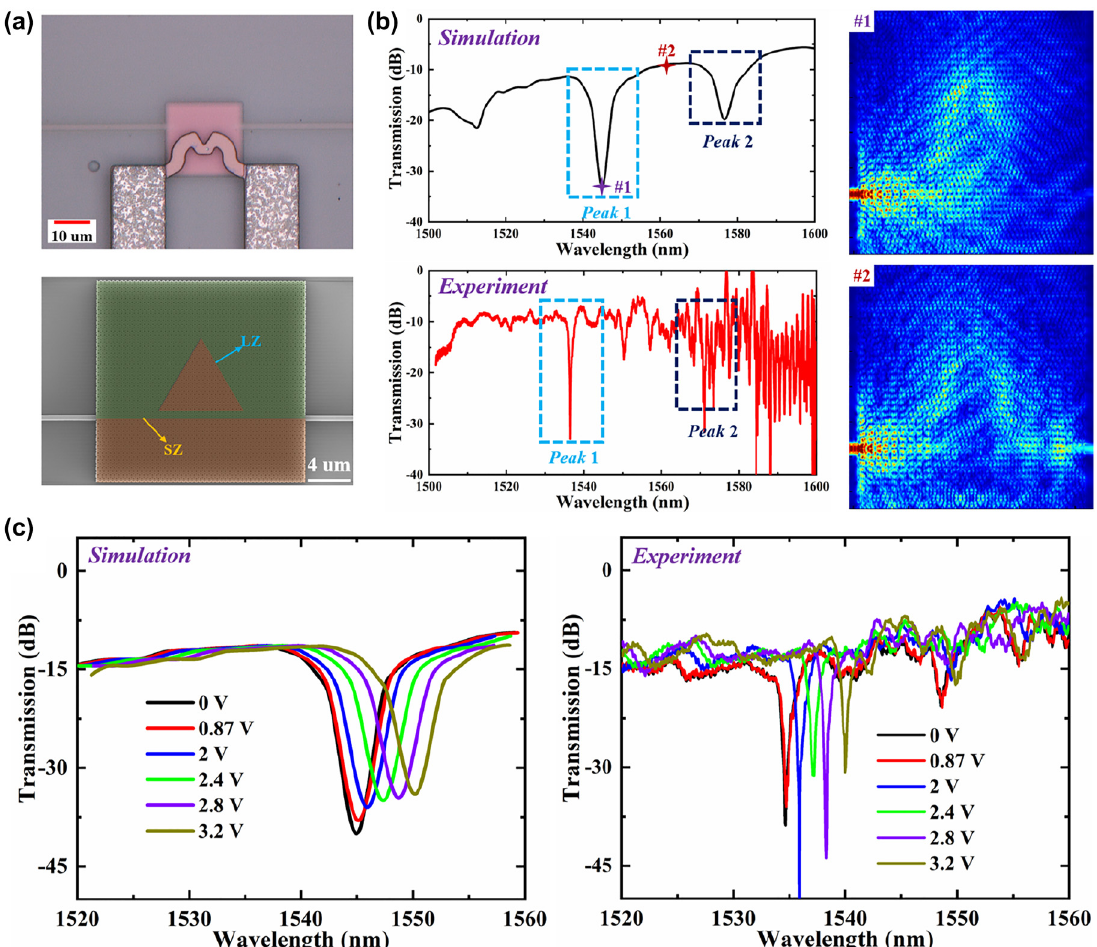
Figure 7: Electrical tuning of the topological MRM. (a) The microscope and SEM images of the VPC-based topological MRM consisting of a straight domain wall constructed by the SZ-interface and a triangular-shaped cavity constructed by the LZ-interface. (b) Simulated and experimental transmission spectra of the MRM in the wavelength range of 1500–1600 nm. The simulated electric field distributions in the topological MRM for the wavelengths corresponded to #1 and #2 shown in the simulated transmission spectrum. (c) Simulated and experimental transmission spectra of the MRM with different applied DC voltages in the wavelength range of 1520–1560